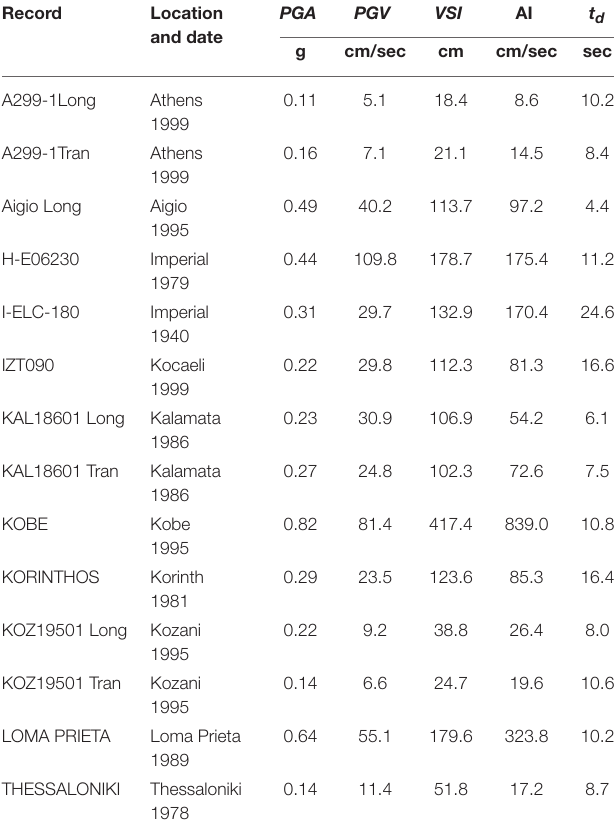
TABLE 2 | Ground motion characteristics of the fourteen acceleration records used in